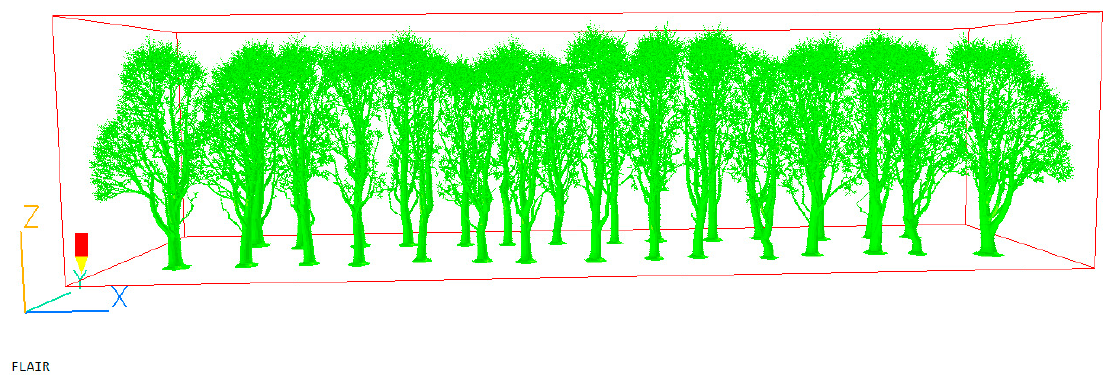
Figure 7. Computational domain; the simulated wind direction was set to 157.5 ◦ based on the average of the measured wind direction. The length, width, and height of the calculation domain were 200 m × 150 m × 50